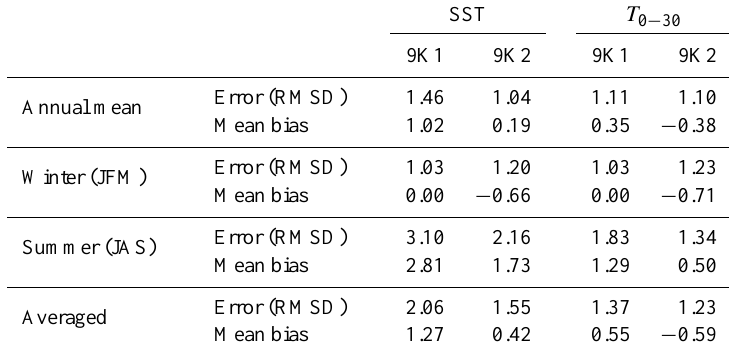
Table 3. Mean error and mean biases